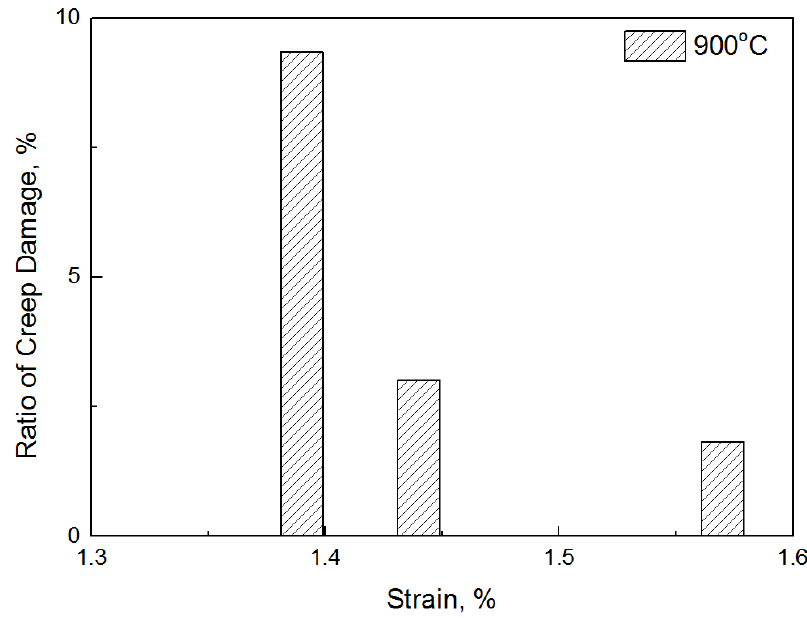
Figure 10. Ratio of damage caused by creep ( Σ D creep ) at 800°C.